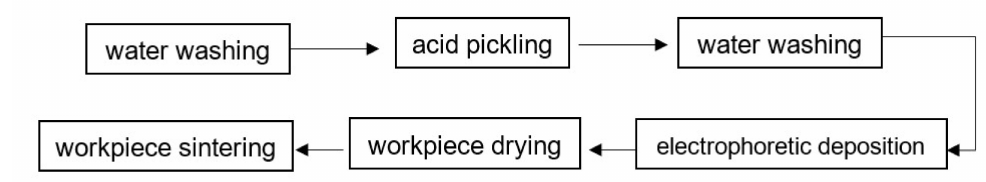
Figure 6. Coating experiment